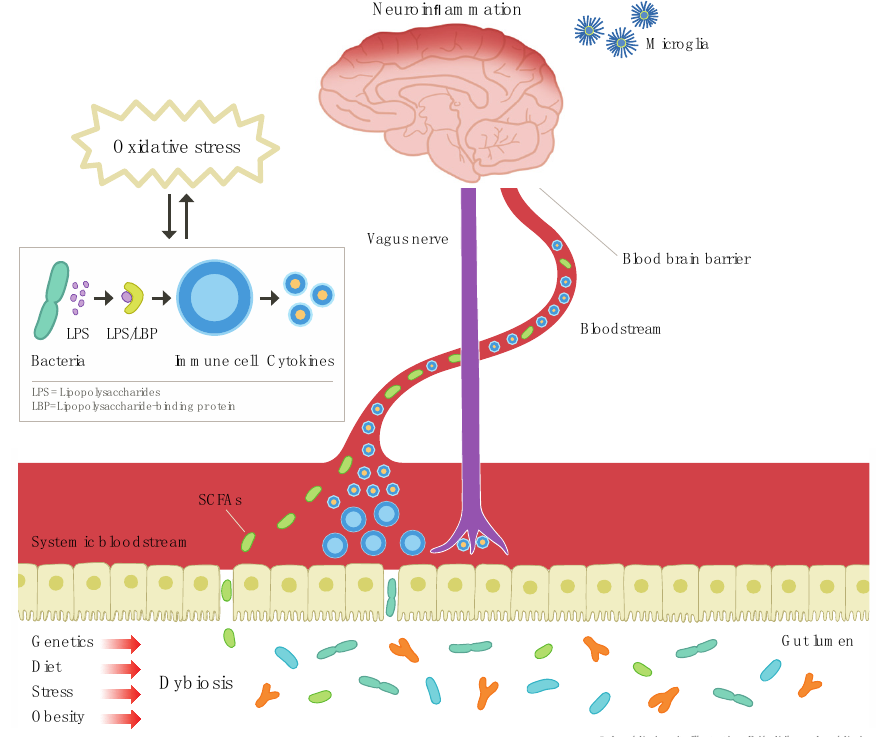
Figure 2. Dysbiosis and increased gut permeability may lead to translocation of LPS from the gut lumen into the circulation triggering low-grade inflammation. SCFAs also translocate into circulation and may have several beneficial effects including enhancing the integrity of the intestinal barrier and the BBB. Circulating pro-inflammatory cytokines either signal to the brain via the vagal nerve or cross the BBB and thereby contribute to neuroinflammation and microglia activation. Abbreviations: lipopolysaccharides (LPS), short-chain fatty acids (SCFAs), lipopolysaccharide-binding protein (LBP), blood-brain barrier